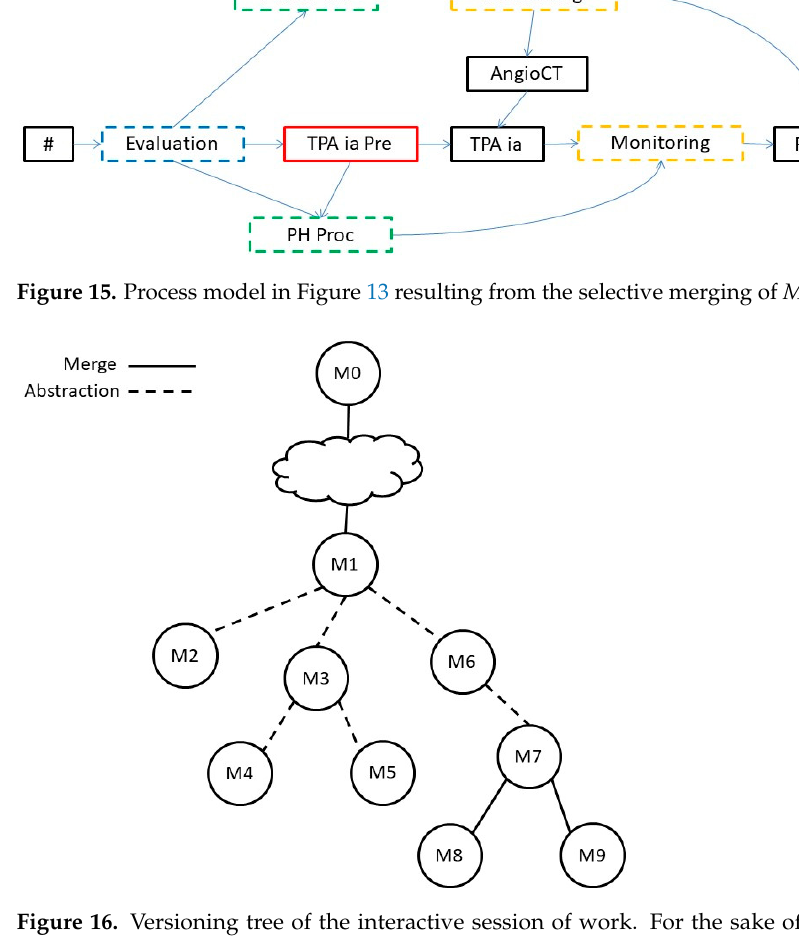
Figure 16. Versioning tree of the interactive session of work. For the sake of brevity and clarity, we represent as a cloud the sequence of nodes resulting from the application of the set of merging operations, as discussed in Section 3.4.